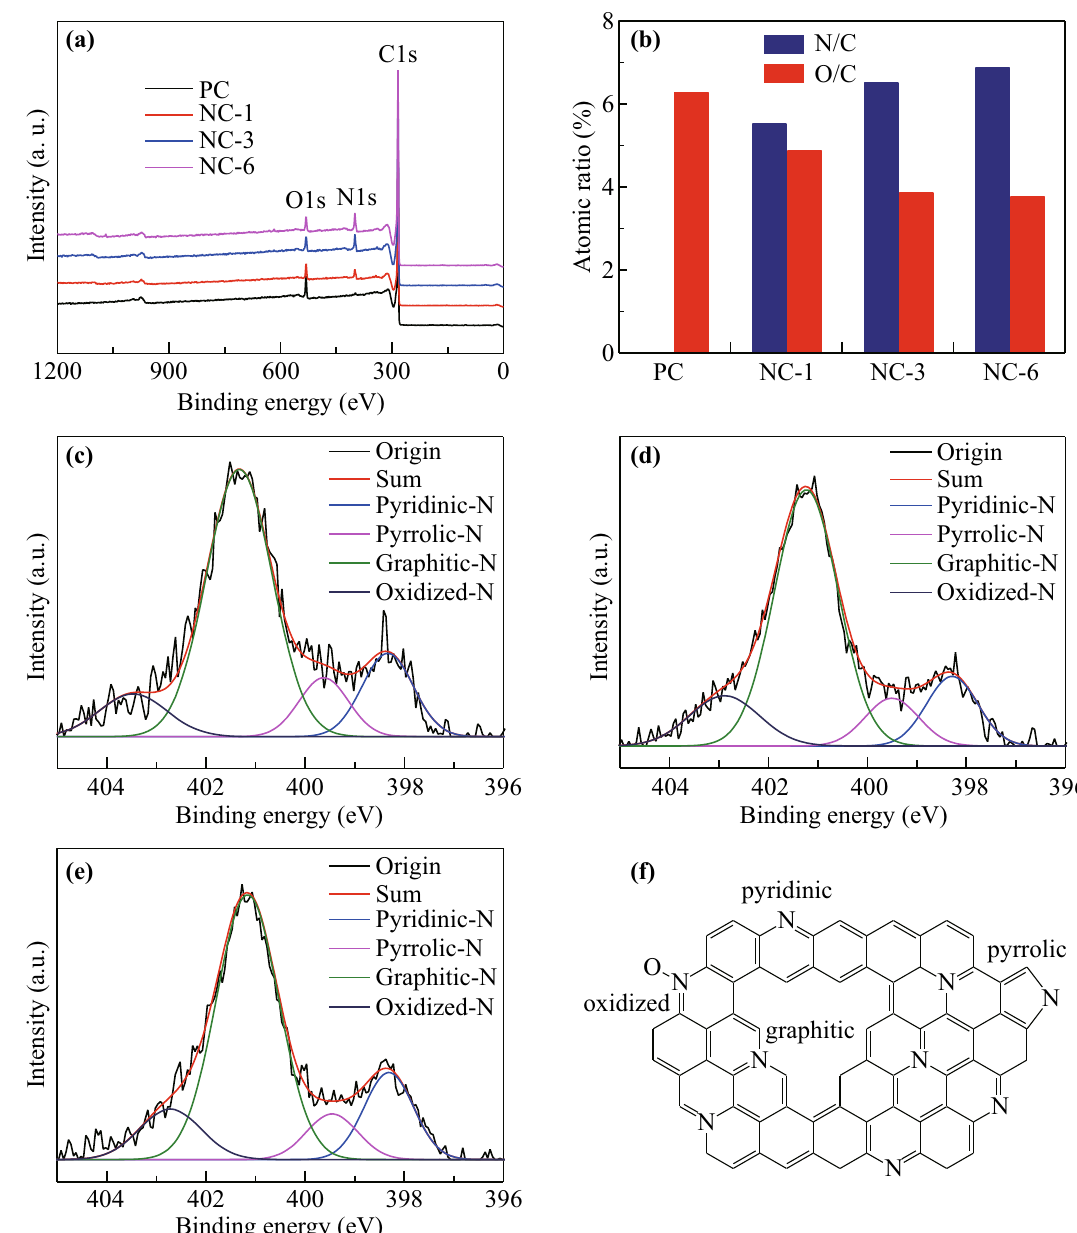
Fig. 3 a XPS survey spectra of PC, NC-1, NC-3, and NC-6. b Atomic ratio of O/C and N/C in PC, NC-1, NC-3, and NC-6. High-resolution XPS spectra of N 1 s for c NC-1, d NC-3, and e NC-6. f Schematic illustration of N-containing species incorporated in the graphene plane of the NC- X